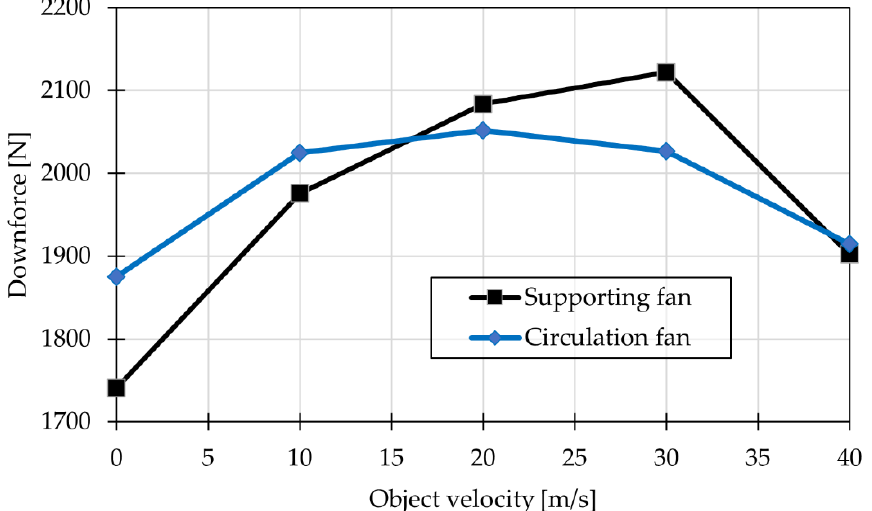
Figure 18. Variation of aerodynamic downforce values produced by a shell object moving at different speeds with the chamber front curtain fed by a supporting fan or circulation fan.